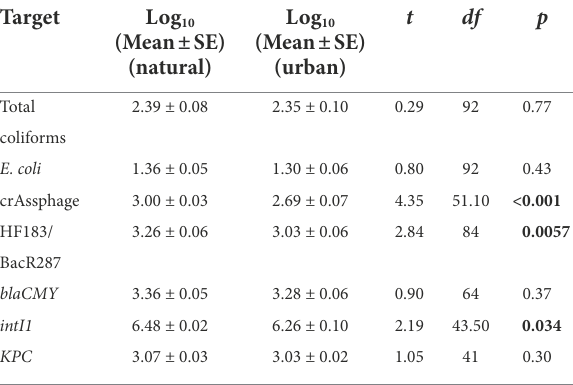
TABLE 2 Comparison of fecal indicator bacteria (FIB; CFU per 100 ml), microbial source tracking (MST) markers (copies per 100 ml),